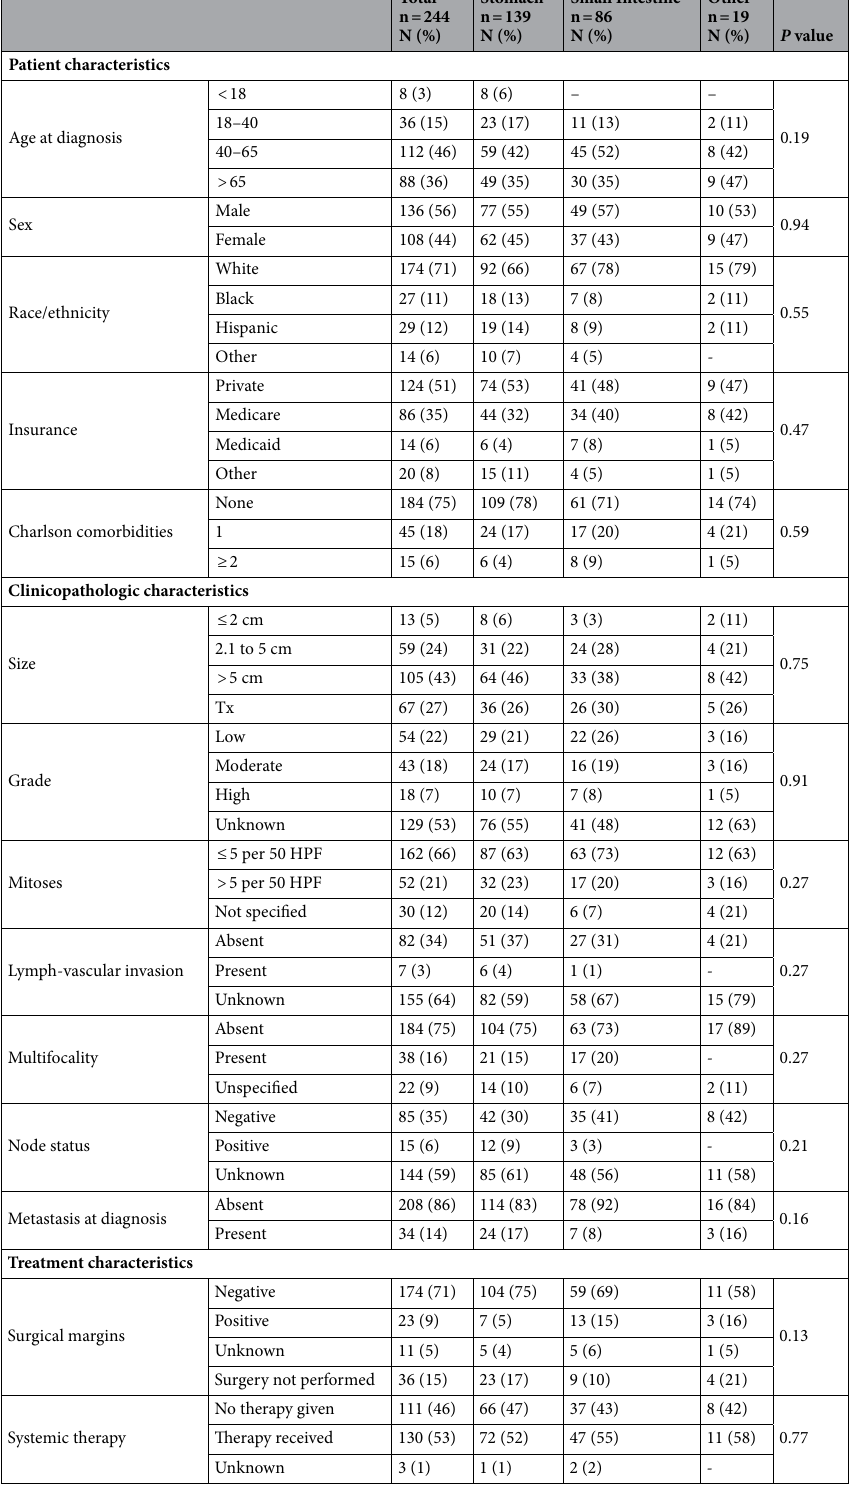
Table 1. Patient demographics, clinicopathologic characteristics, and treatment characteristics, overall and by primary site. HPF high-power